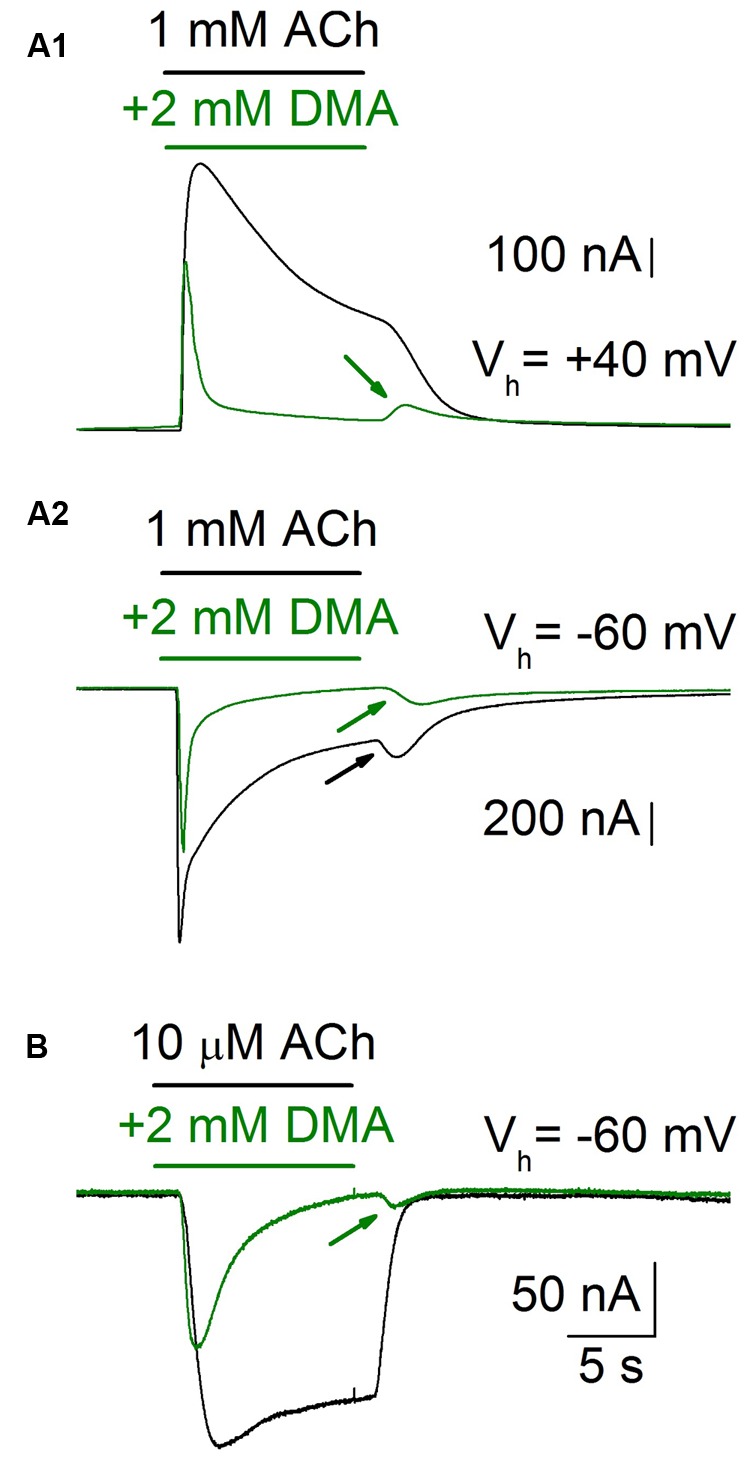
IACh rebound elicited by DMA washout. When an oocyte was challenged with a high ACh concentration (1 mM), while holding its membrane potential at -60 mV (Vh = -60 mV), the IACh showed a marked desensitization and a noticeable rebound-current (A2, black recording and arrow) when the agonist was rinsed. By contrast, both when applying the same ACh concentration to the cell at a membrane potential of +40 mV (A1, black recording), or when decreasing the ACh concentration to 10 μM (B, black recording), the IACh rebound was not evoked. However, when ACh was co-applied with 2 mM DMA the IACh rebound was evident at any potential or ACh concentration tested (A1,A2,B, green recordings and arrows).